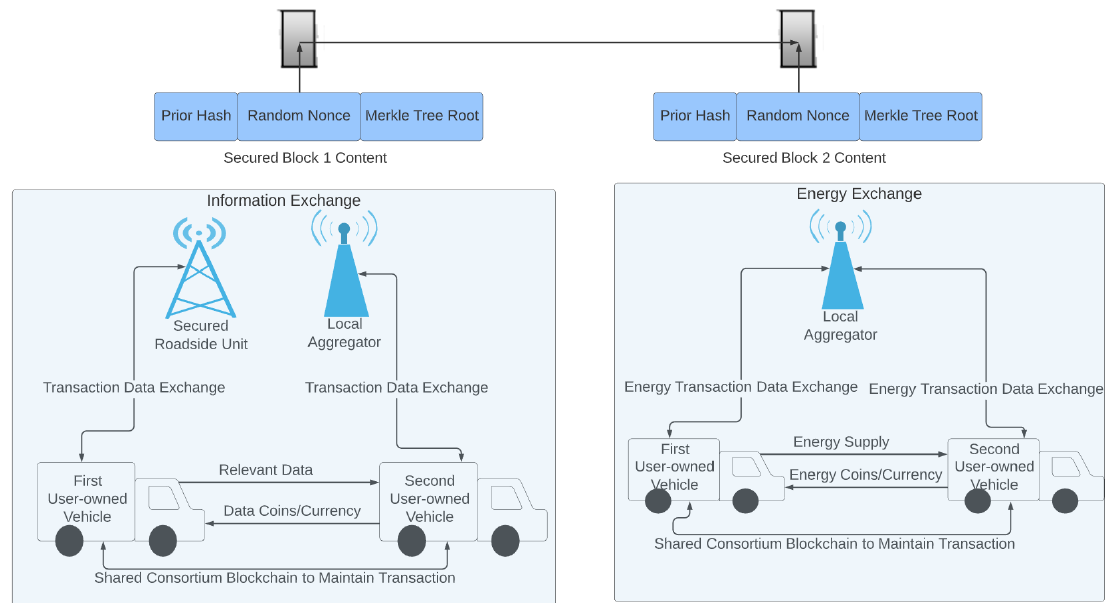
Figure 13. A model showing how energy and information is exchanged over the network using blockchain, inspired by [83].